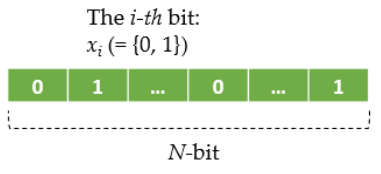
Figure 4. A chromosomal design encoding x i ( t ) (at time t ) in Equation (2).